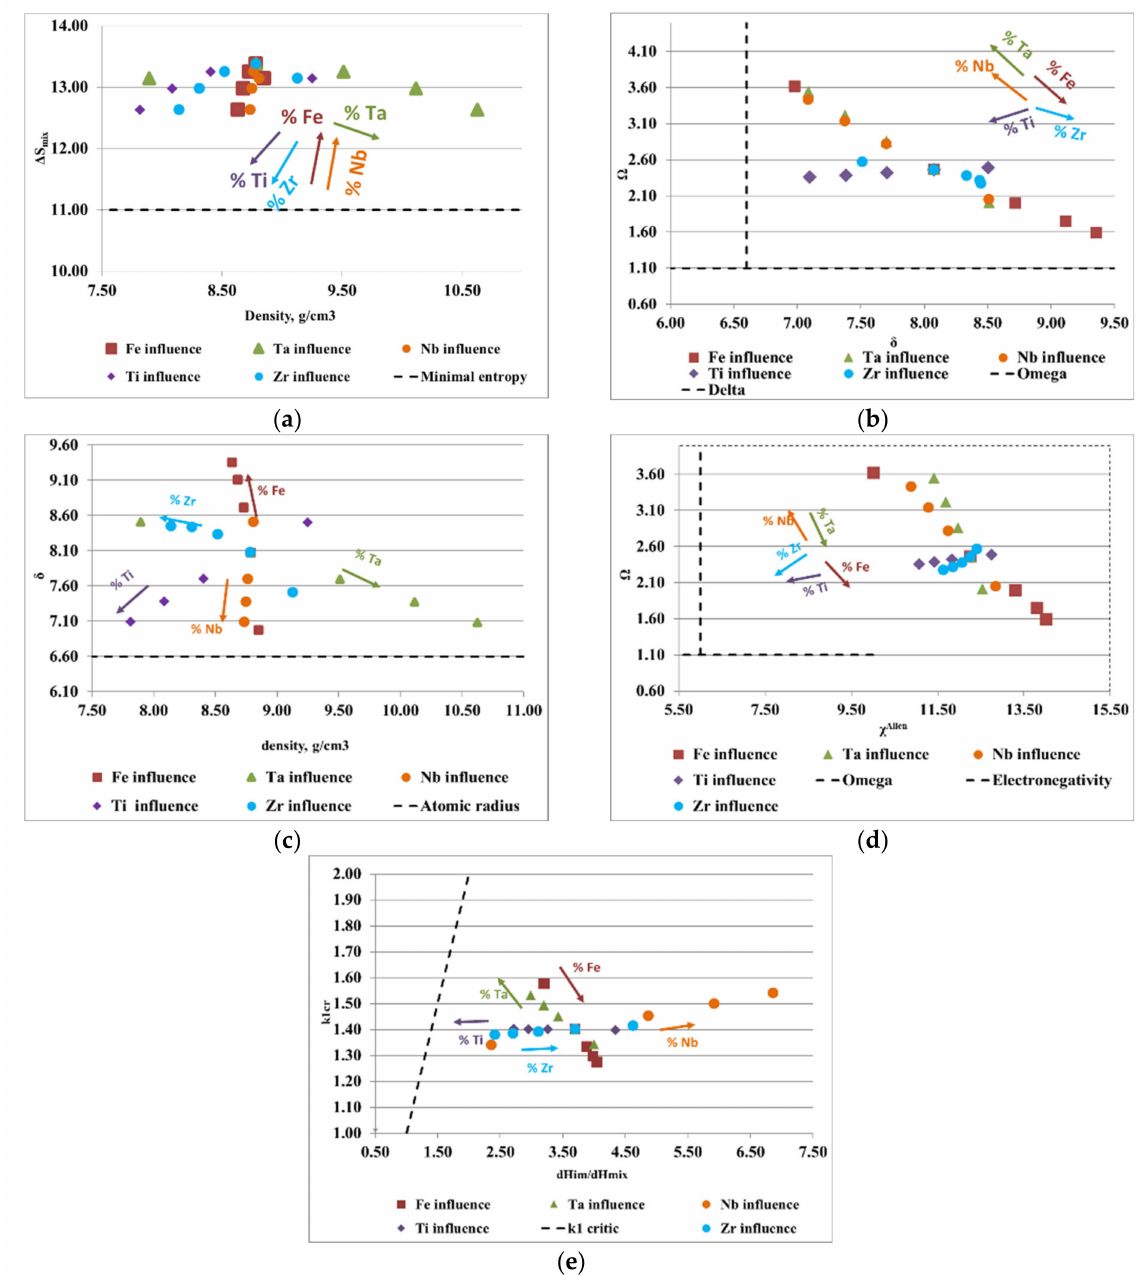
Figure 3. Graphical representation of the variations between ( a ) density, ρ , and the configurational entropy, ∆ S mix ; ( b ) the atomic radius difference, δ , and the derived parameter, Ω ; ( c ) density, ρ , and the atomic radius difference, δ ; ( d , e ) the ratio between the enthalpy of intermetallic compounds ( ∆ H im ) and the mixing enthalpy ( ∆ H mix ) with the k1 cr factor for the FeTaNbTiZr alloy